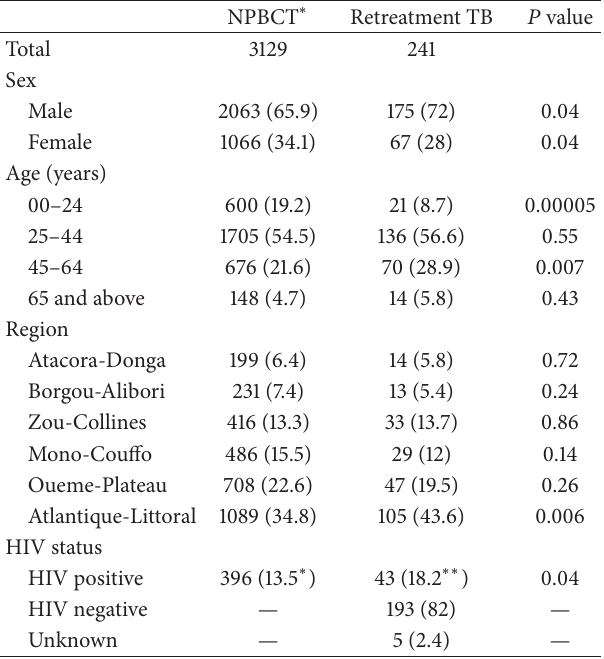
Table 2: Demographic characteristics and HIV status of new pul- monary bacteriologically confirmed and retreatment tuberculosis patients, Benin,